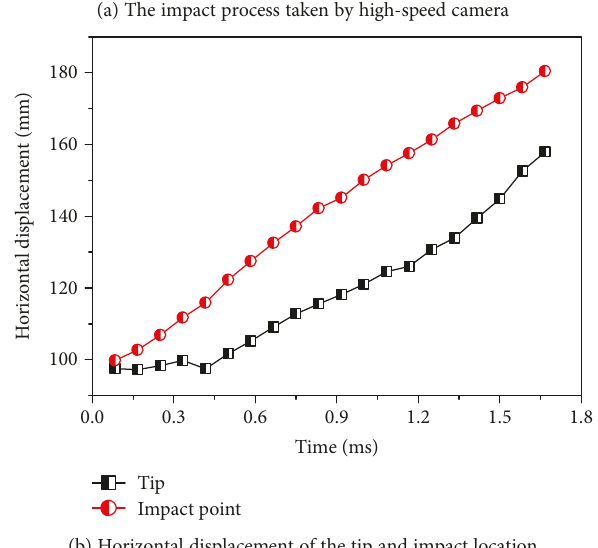
Figure 7: The bird impact process of the braided composite in B20-02